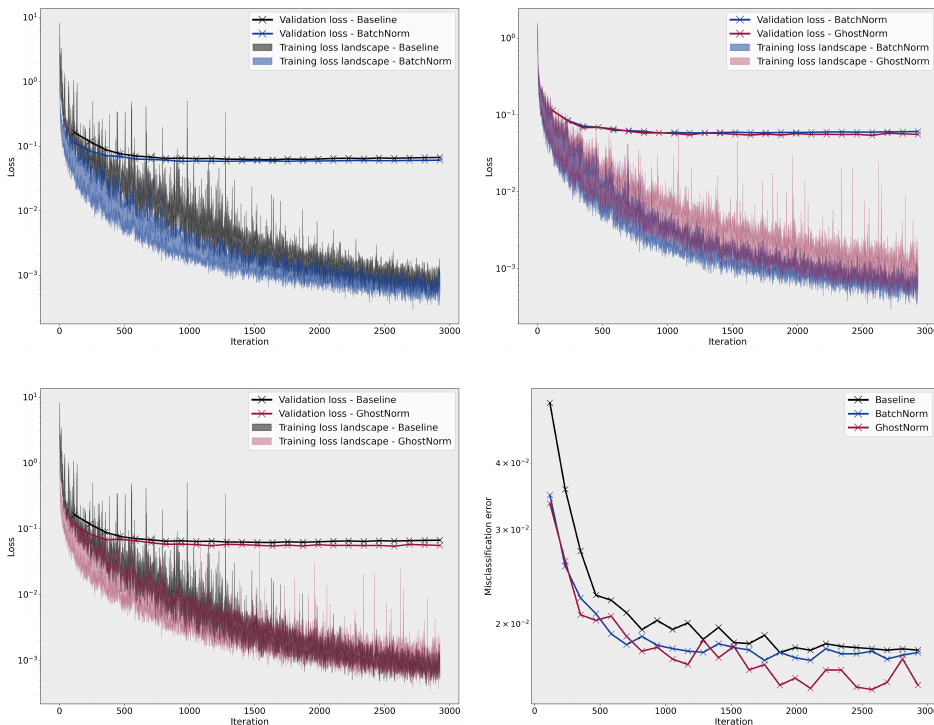
Figure 2. Comparison of the loss landscape on MNIST between BatchNorm, GhostNorm, and the baseline.